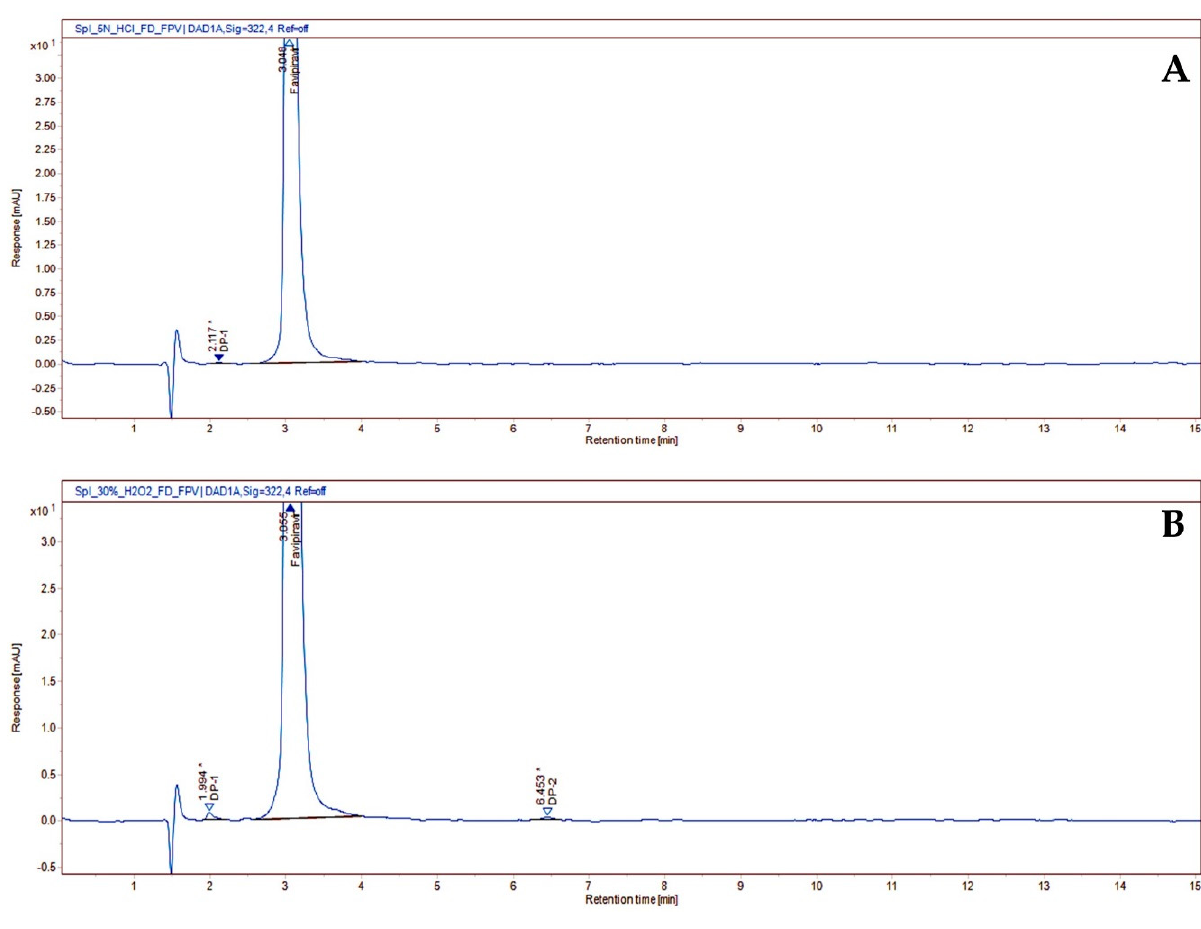
Figure 3. Chromatogram of alkali degradation under 5 N NaOH of favipiravir in its oral suspension.